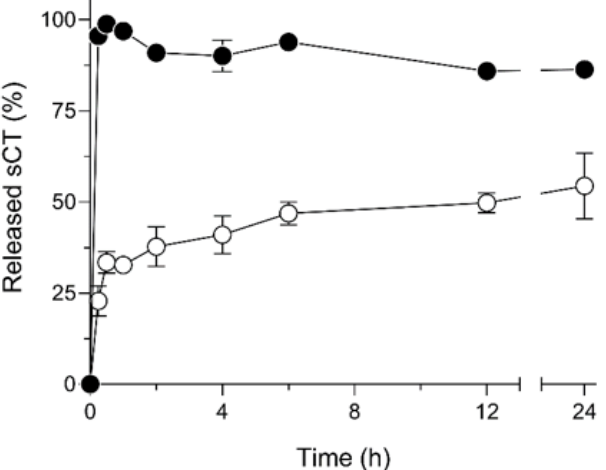
Figure 3. In vitro release behavior of sCT from PLGA microparticles in simulated lung fluid. ●, sCT powder; and ○ , sCT/SR. Each bar represents mean ± SE of 3 independent experiments.